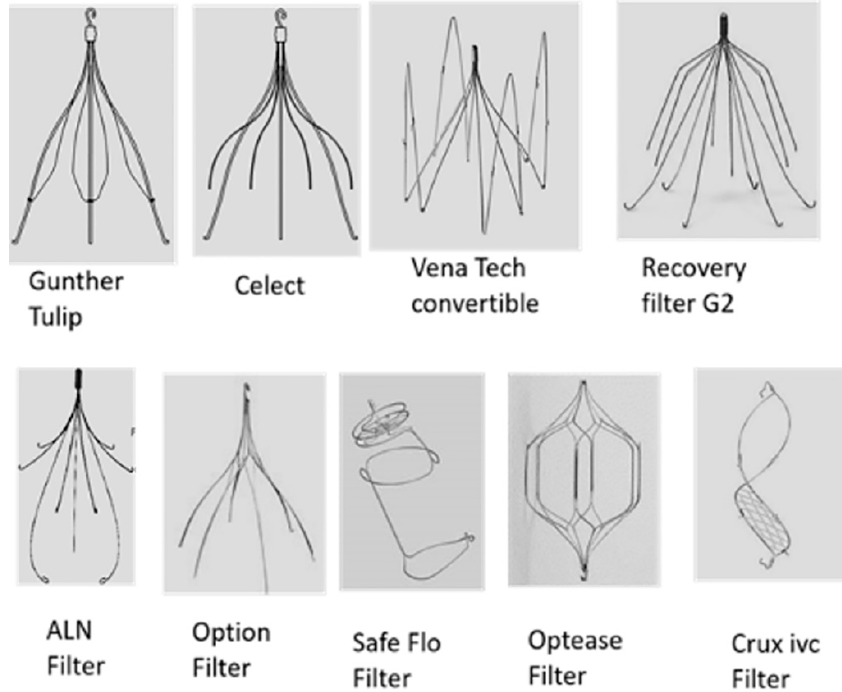
Figure 1. Different types of filters available for the treatment of venous thromboembolic disease. Box 1. SIDI & SERVEI